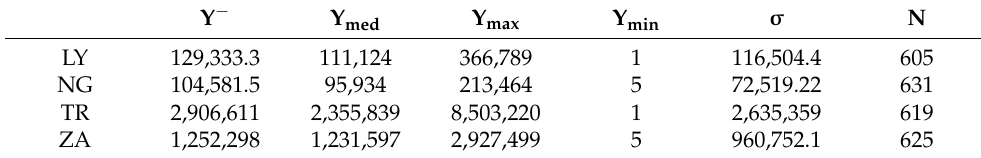
Table 1. Descriptive statistics of the